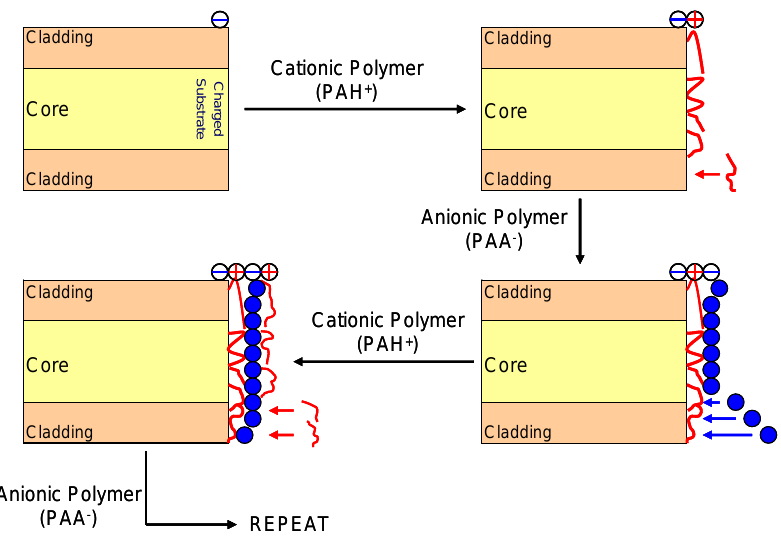
Figure 3. Schematic of the ESA deposition process onto the cleaved end of a fiber optic. The symbols are idealized and not intended to represent exactly the conformation of the polyelectrolyte